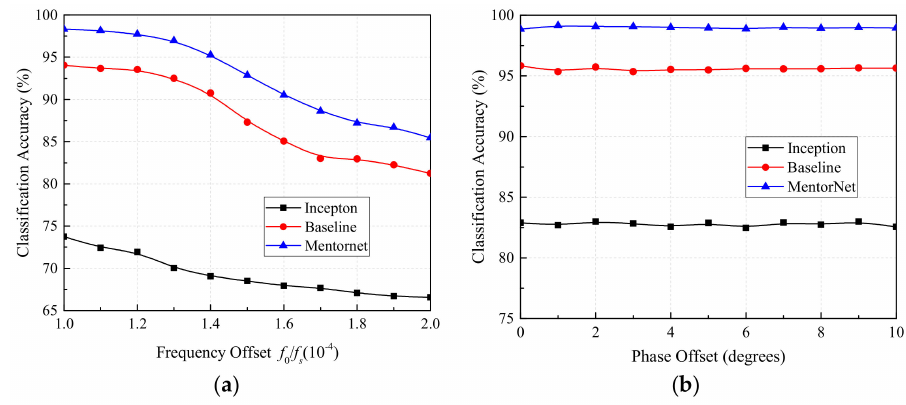
Figure 12. Classification accuracy with ( a ) di ff erent carrier frequency o ff sets and ( b ) di ff erent phase o ff sets.